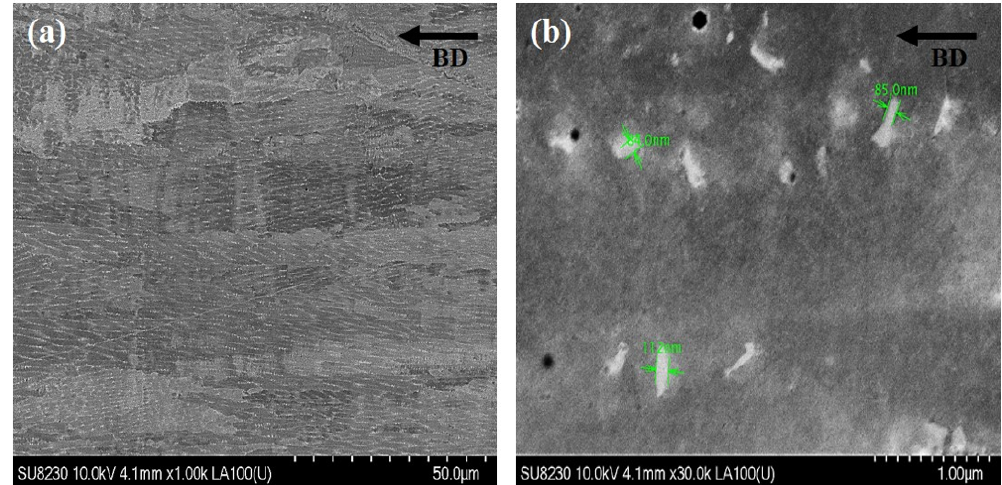
Figure 6. FE-SEM micrographs from the microstructure of the as-SLM IN718 sample. ( a ) Dendritic structure and ( b ) particles at the interdendritic regions.